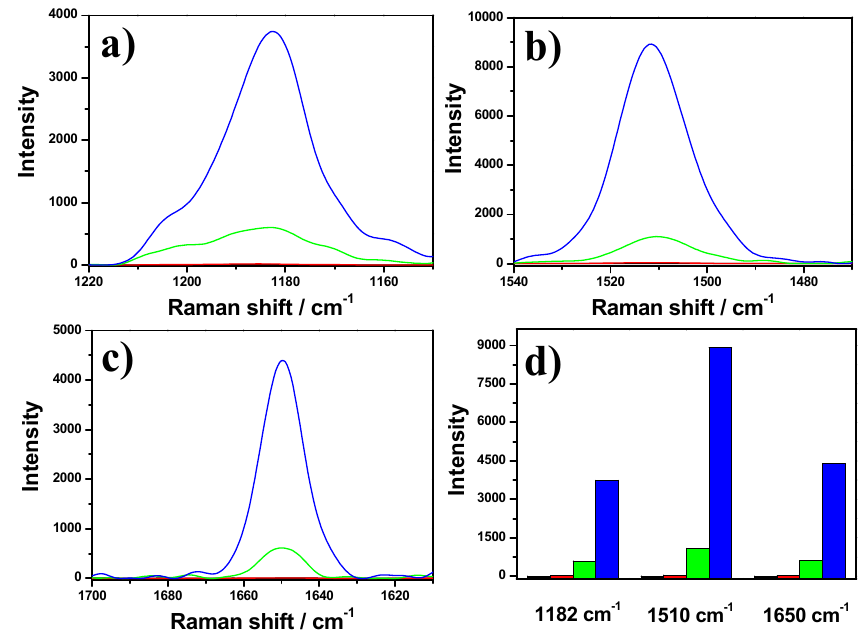
Figure 8. Raman spectra of Rh6G (1 × 10 − 4 M) deposited onto NIF-H (black curve), MIF-H (red curve), NIF@GO-AgNPs (green curve), and MIF@GO-AgNPs sample (blue curve) related to three Raman modes centered at 1182 cm − 1 ( a ), 1510 cm − 1 ( b ), and 1650 cm − 1 ( c ). ( d ) Bar plot comparing the signal intensities obtained from NIF-H (black bar), MIF-H (red bar), NIF@GO-AgNPs (green bar), and MIF@GO-AgNPs (blue bar) taken for the different Raman modes.